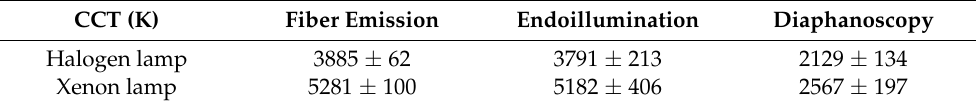
Table 1. Direct comparison of correlated color temperature (CCT) of the light emission in front of an ophthalmological fiber in combination with a halogen light source and a xenon light source to the CCT inside the eye during endoillumination and with diaphanoscopic illumination.